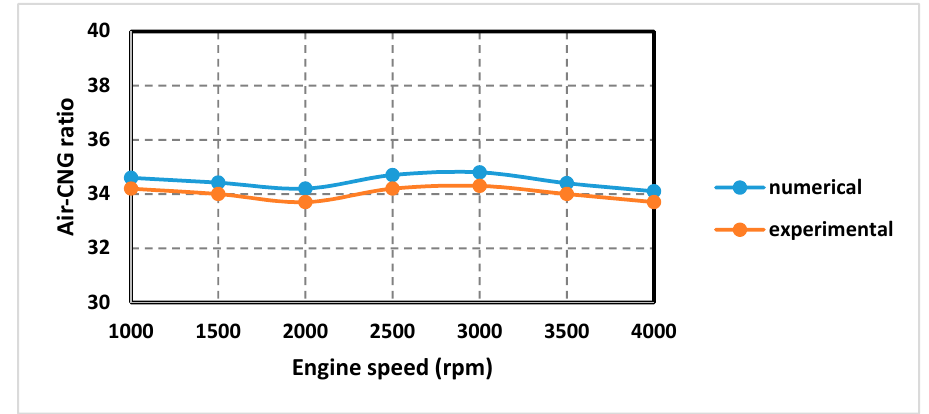
Figure 19. Photograph of the mixer test rig components from 1 to17 ( CNG cylinder, air inlet ,air mass flow meter, Vernier caliper , Mixer, CNG mass flow meter, Laptop, CNG pressure regulator, Pressure gauges, Manometer, Visible pipe, Black wall, Blower, Mixture outlet after mixer (CNG and Air), Mixture outlet after blower (CNG and Air), CNG inlet inside the mixer,and protractor, respectively) .